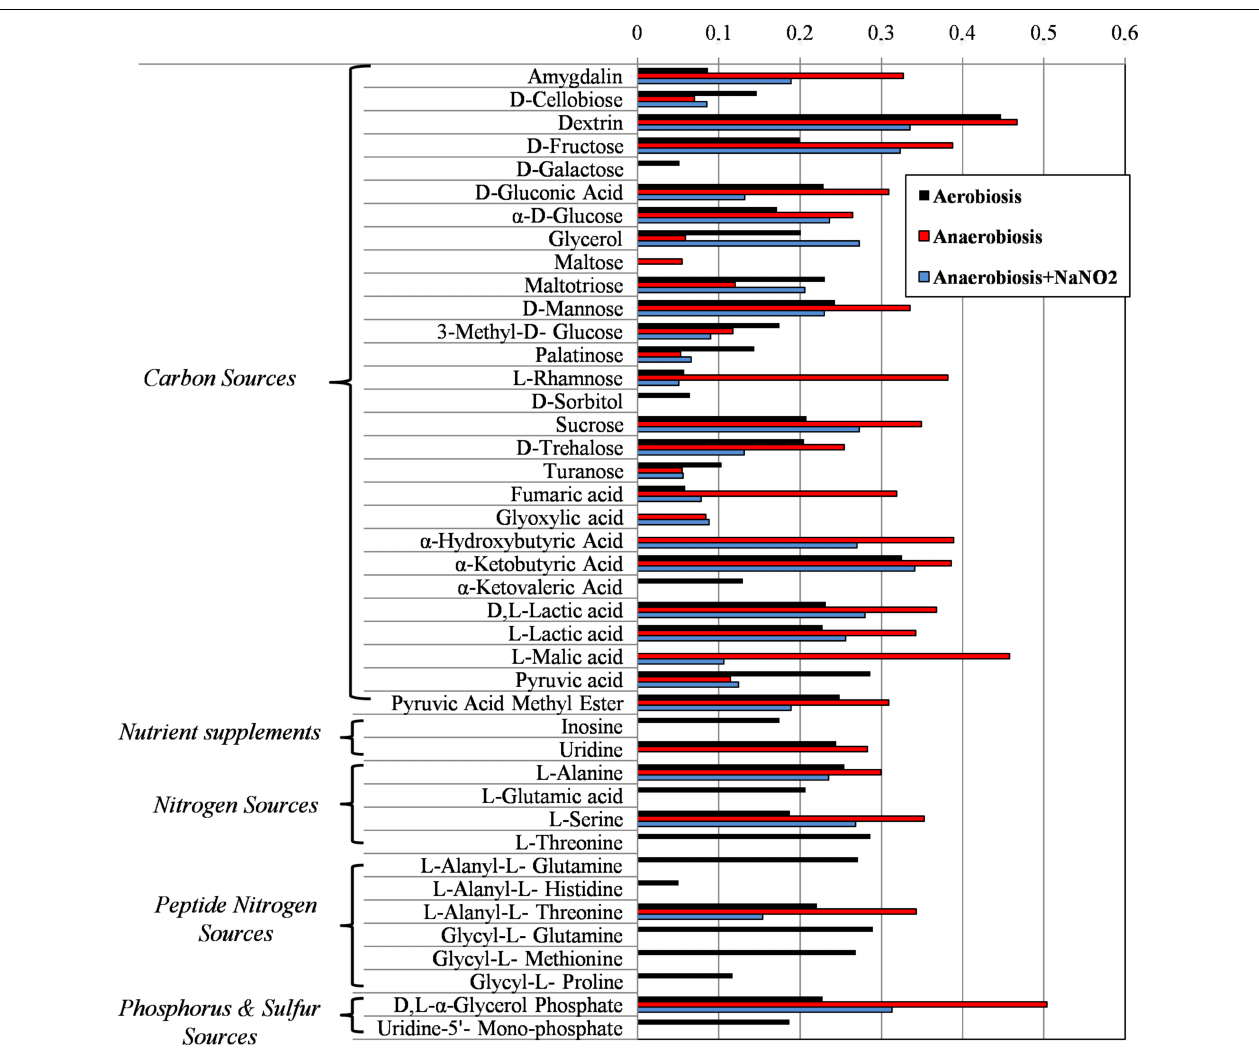
The nitrite metabolism is correlated with the activation/repression of O 2 dependent or redox sensors, such as NreABC and Rex- NAD + /NADH sensors,